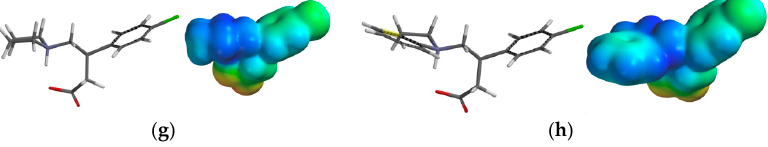
Figure 5. Optimized structures and MEP of all analogues under study in their Zwitterionic form. Red, blue and green color indicates negative, positive and neutral charged regions, respectively. ( a ) ( S )–VGB 4 ; ( b ) VPNa 5 ( c ) 9a ; ( d ) 9b ; ( e ) 18a ; ( f ) 20b ; ( g ) 19a ; ( h ) 21b . MEP values bars are shown.